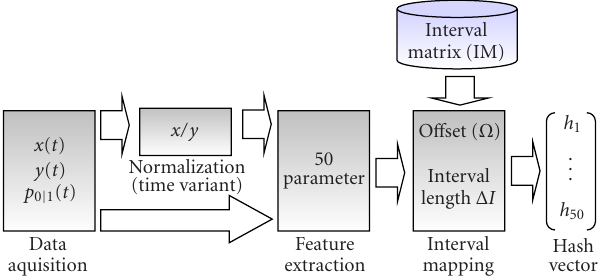
Figure 1: Process of the biometric hash